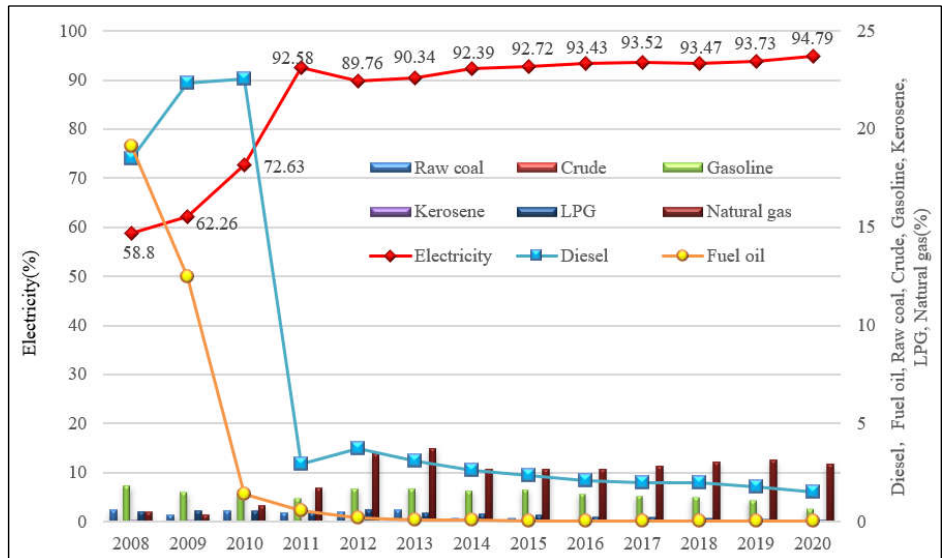
Figure 2. CO 2 emissions proportions of various energy sources in Shenzhen’s manufacturing.